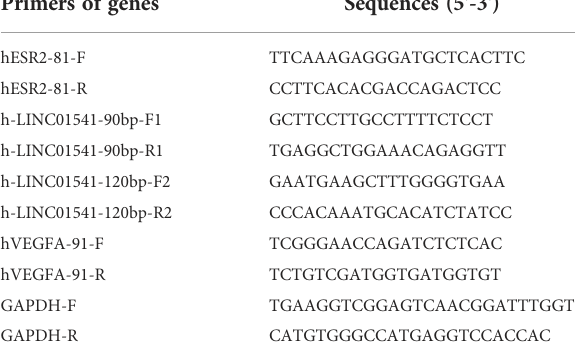
TABLE 2 Primers used in the